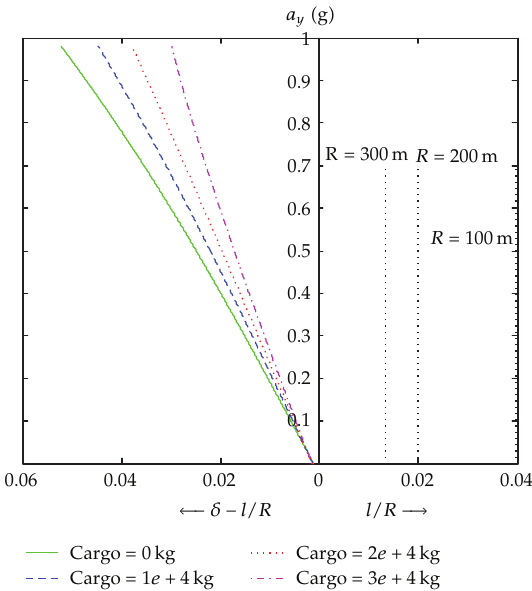
Figure 7: R -handling diagram for tractor semitrailer with two rear